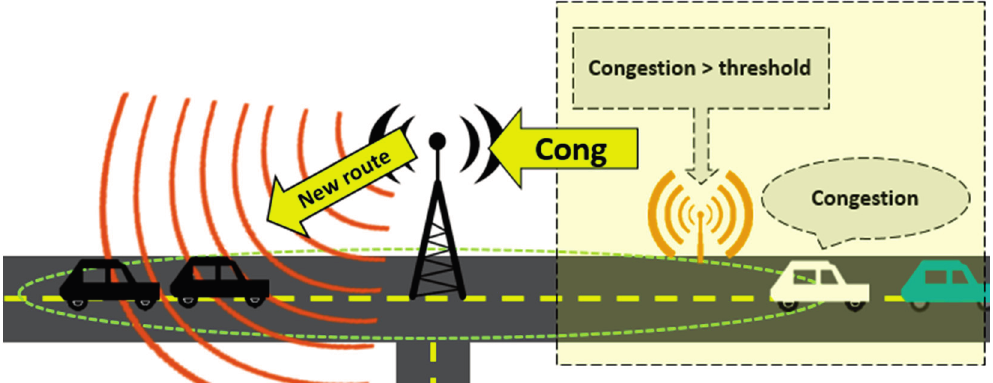
Figure 15. Route recalculation